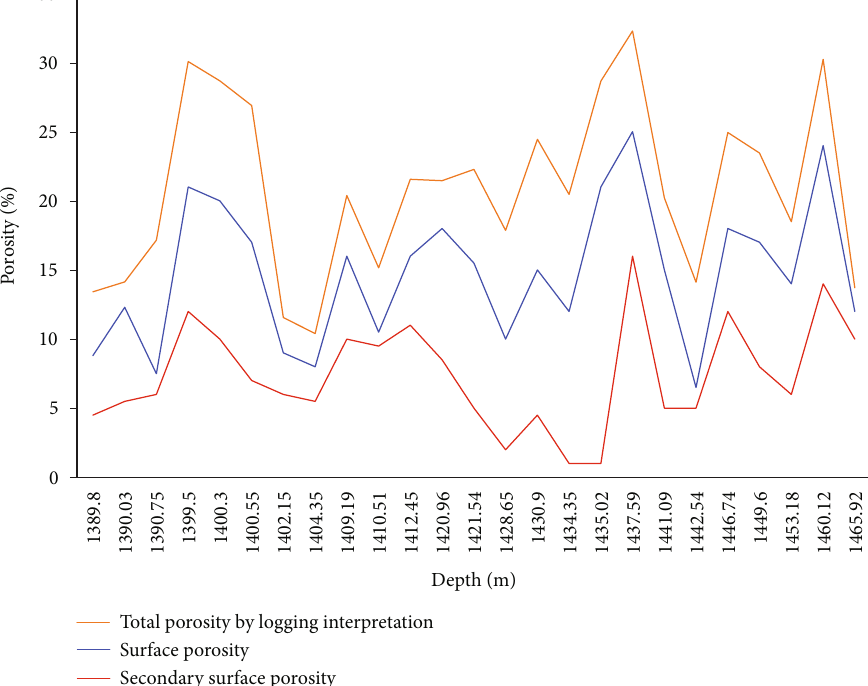
Figure 6: Trend charts of surface porosity, secondary surface porosity, and total porosity by logging interpretation of casting thin section with depth.